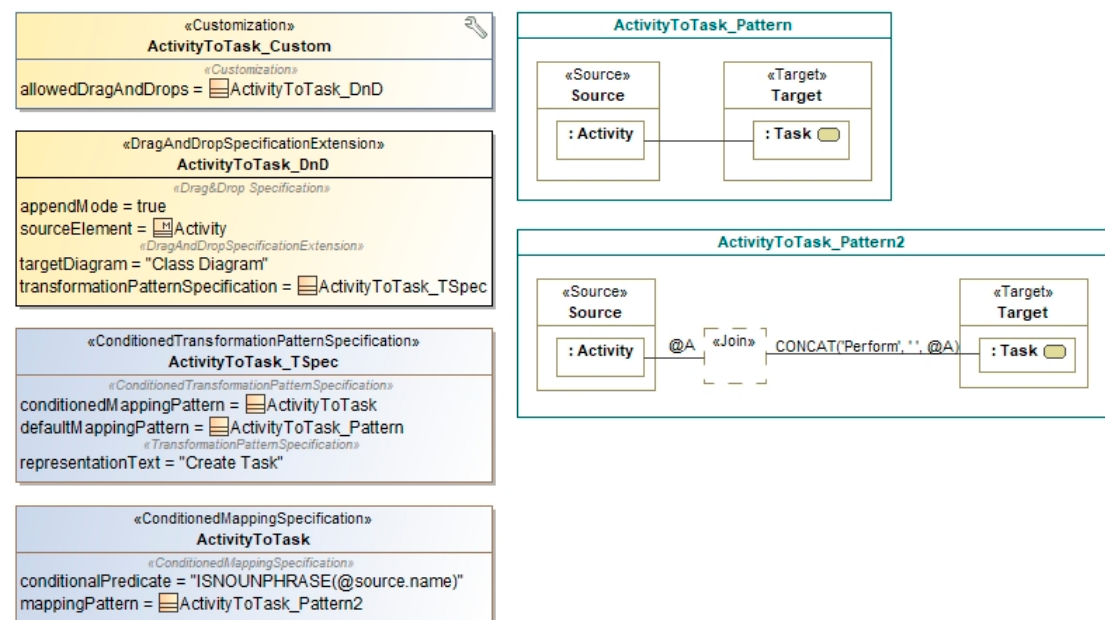
Figure 9. M2M transformation specification for UML Activity to business process model and notation (BPMN) Task transformation.